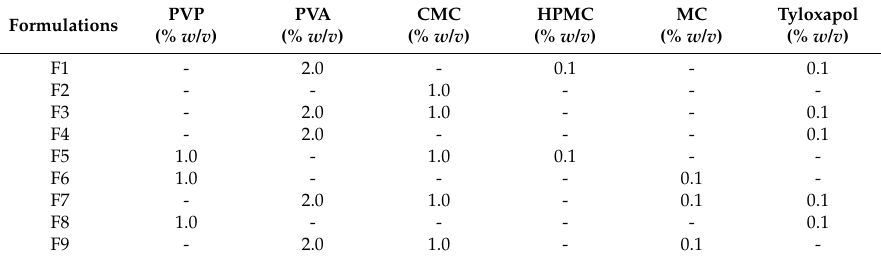
Table 1. Polymer composition of the nine eye drop